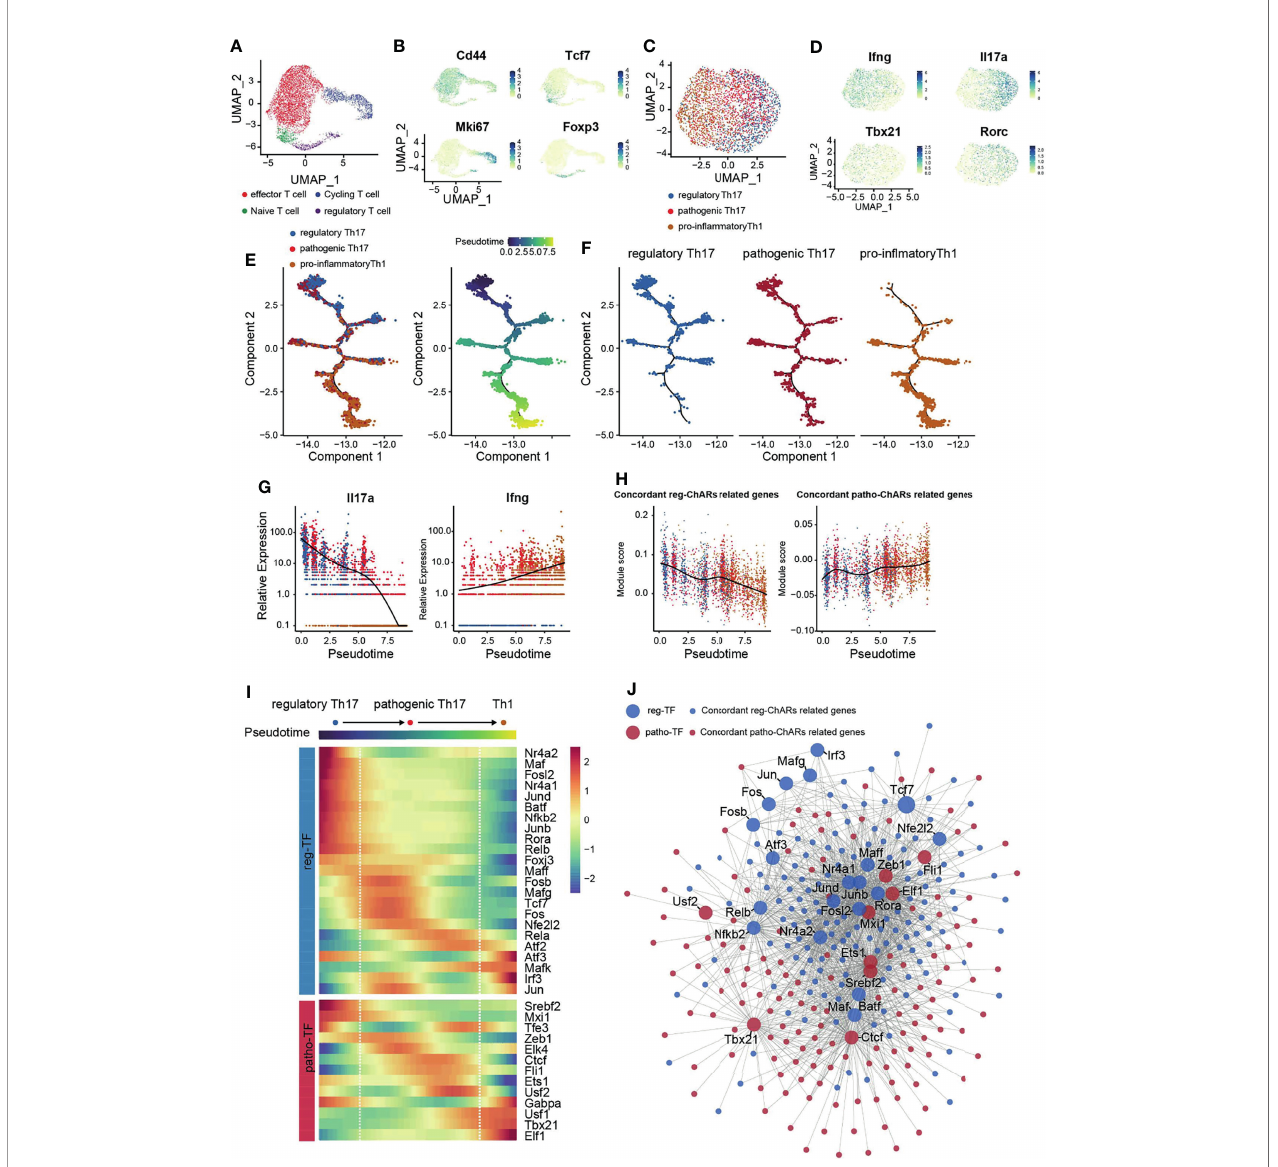
FIGURE 5 | Single-cell transcriptome corroborates a regulatory network change from a reg-TF operated manner to a patho-TF operated manner during the Th17 to Th1 Conversion. (A) Single-cell transcriptome (scRNA-Seq) of CD4 + T cells in the CNS of EAE mice. (B) Expression of Cd44 , Tcf7 , Mki67 , and Foxp3 in CD4 + T cells in the CNS of EAE mice. (C) Evaluation of regulatory Th17, pathogenic Th17, and pro-in fl ammatory Th1 features in cells isolated from the Teff cluster. (D) Expression of Ifng , Il17a , Tbx21 , and Rorc in the isolated cells from the Teff cluster. (E) Pseudotime analysis of the isolated regulatory Th17, pathogenic Th17, and pro-in fl ammatory Th1 cells. Each dot represents an individual cell, colored by cluster (left) or by pseudotime(right). (F) Distribution of regulatory Th17, pathogenic Th17, and pro-in fl ammatory Th1 cells along the pseudotime trajectory. (G) Dynamic expression change of Ifng and Il17a along the pseudotime trajectory. (H) Dynamic change of patho-ChARs and reg-ChARs related gene features along the pseudotime trajectory. (I) Heatmap of patho-TFs and reg-TFs along the pseudotime trajectory. (J) Transcriptional regulatory network constructed by patho-TFs and reg-TFs and their targets from patho-ChARs and reg- ChARs related